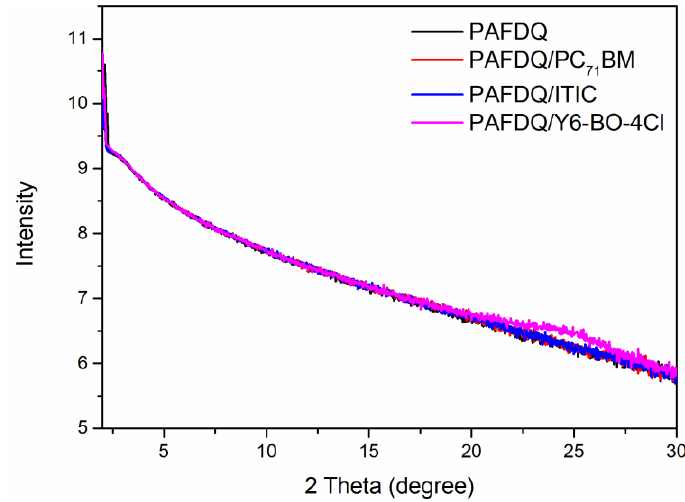
Figure 3. Out-of-plane in X-ray di ff raction pattern in thin films after thermal treatment.